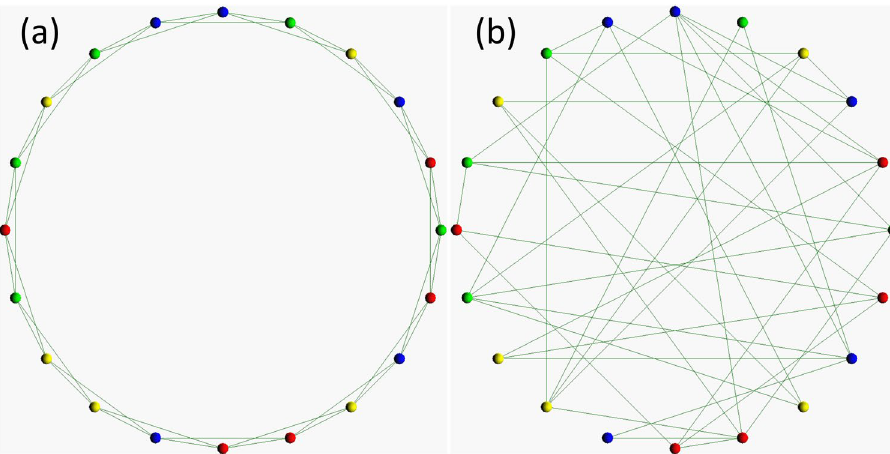
Figure 1. The sample spatial structure of ( a ) the regular and ( b ) the random one-dimensional lattice. The number of players is 1000 in the actual simulations, but it is 20 in this figure. The meaning of each colour is as follows: punishers are shown in blue, defectors are in red, cooperators are in green, and loners are in